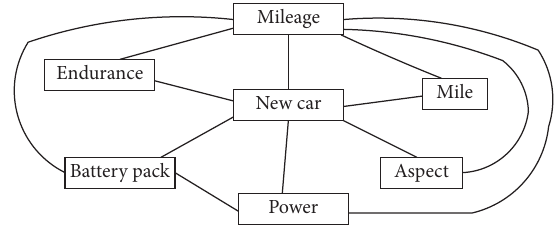
Figure 2: Representation of text graph model. Table 1: The relation table of I